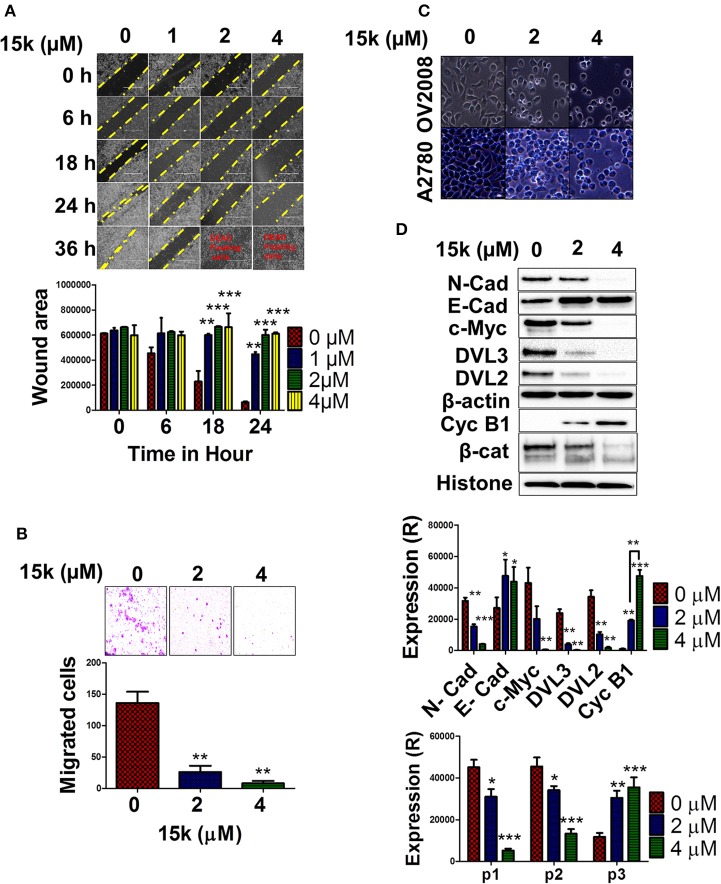
The in vitro effect of 15k on OV2008 migration and invasiveness, as well as EMT/ Wnt/β-catenin proteins; (A) Representative images showing the wound area and closure at different time points (0, 6, 18, 24, and 36 h) after incubation with 15k (0, 1, 2, and 4 μM). Below the images is a histogram quantitatively showing the results and statistical analysis of the data; (B) The transwell migration assay is shown as representative images of the level of cells that have migrated after incubation with 15k (0, 2, and 4 μM). Below the images is a histogram showing the number of cells that have migrated and invaded the membrane inserts (counted/field of image); (C) A representative image of OV2008 and A2780 cell morphology taken from an EVOS microscope (40X) following incubation with 15k (0, 2, and 4 μM). 15k induced cells to transform from a spindle—mesenchymal shape, to a more round, epithelial shape; (D) Western blots for the expression of N-cadherin (N-cad), E-cadherin (E-cad), c-Myc, DVL3, DVL2, Cyclin B1 (Cyc B1) and β-catenin (β-cat) fragmentation. Cells were incubated with (0, 2, and 4 μM) of 15k. β-actin levels were used to normalize cytosolic proteins and histone was used for normalizing nuclear proteins. Below the Western blots is a histogram quantitatively summarizing the results where (R) is for relative. The data are presented as the means ± SEM of three independent experiments. *p < 0.05, **p < 0.01, ***p < 0.001 vs. control group.